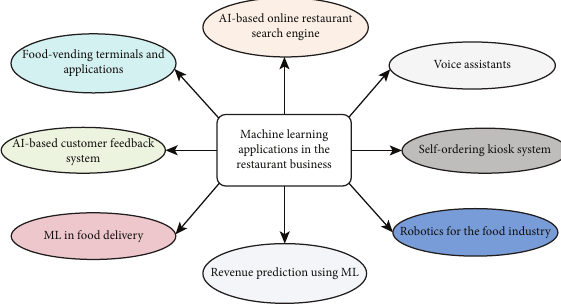
Figure 6: ML application in the restaurant business.